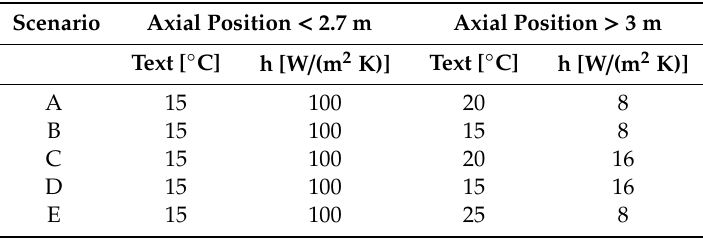
Table 4. Thermal boundary conditions during the simulated